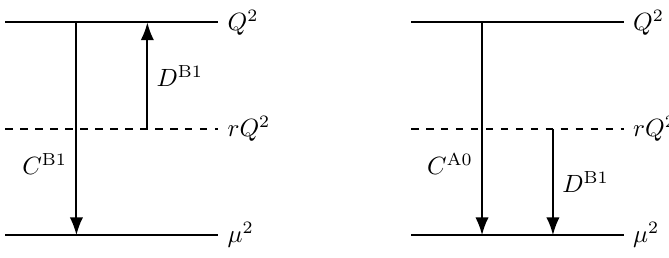
Figure 7 . Graphical illustration of the resummation of the initial condition of the B1 operator for r (cid:28) 1 (left) and the LL-accurate approximate procedure employed